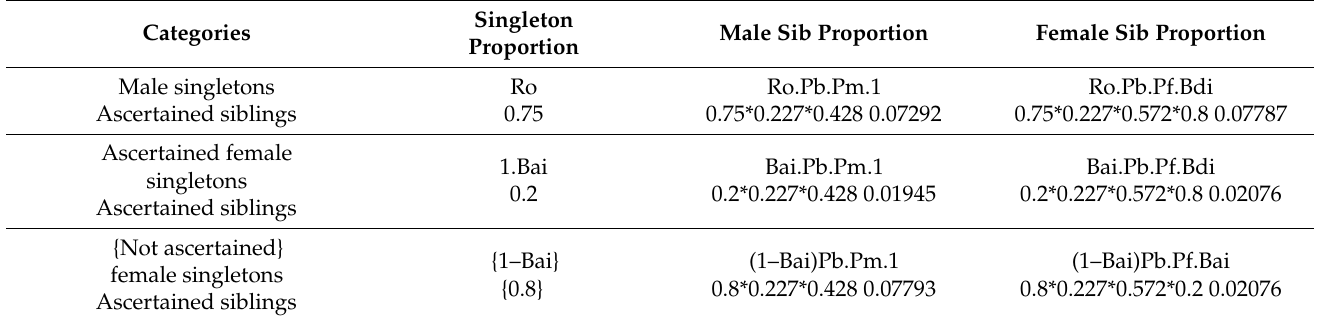
Table A1. The relative proportions of all children with ASD in the population of